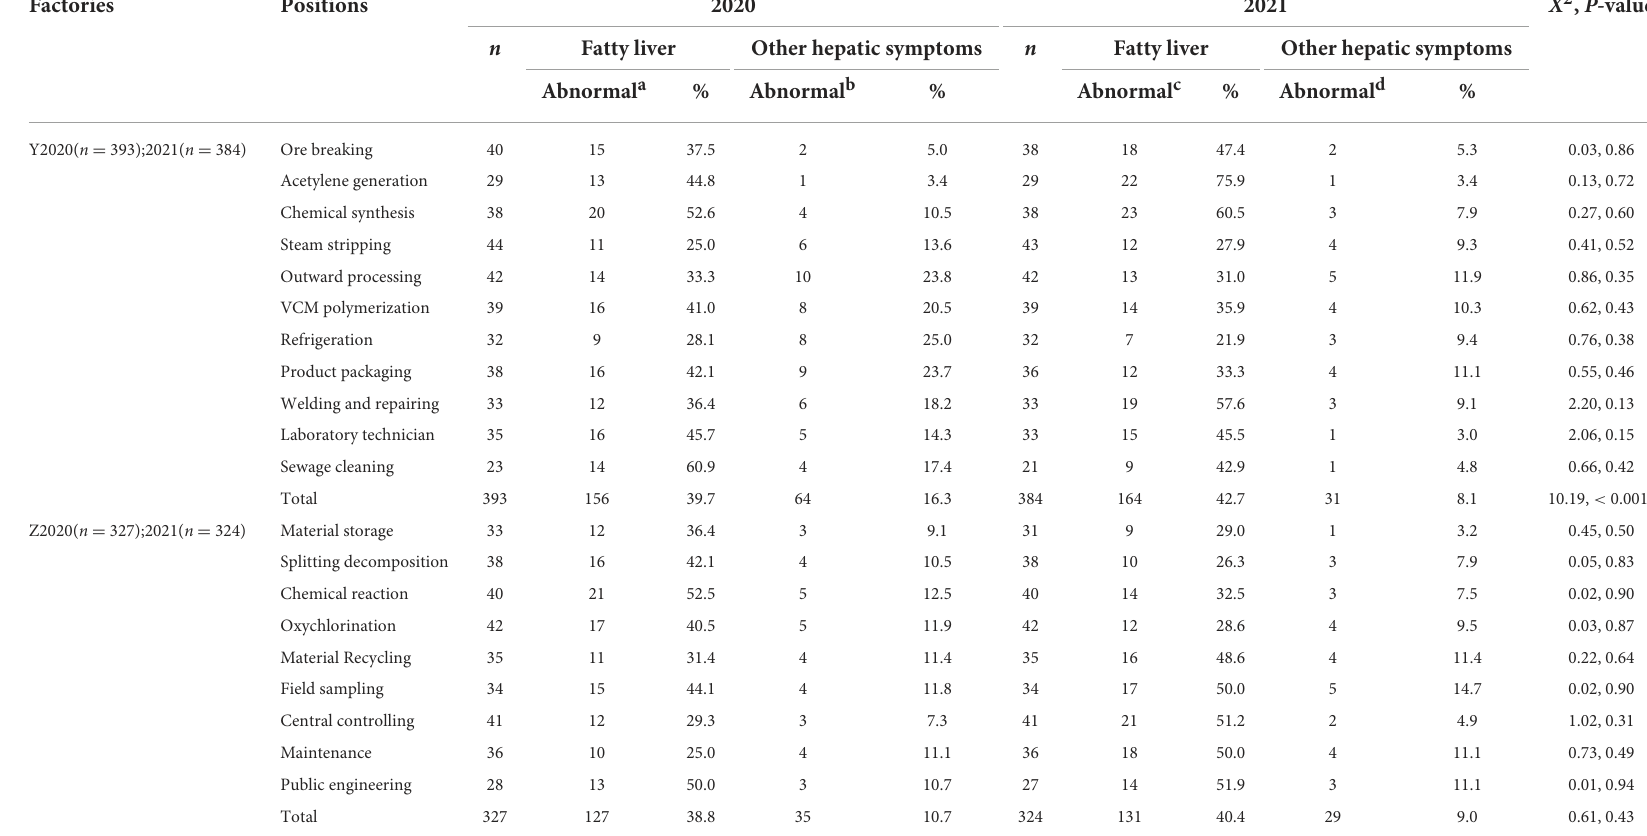
TABLE 10 Results of liver ultrasound analysis in Y and Z between 2020 and